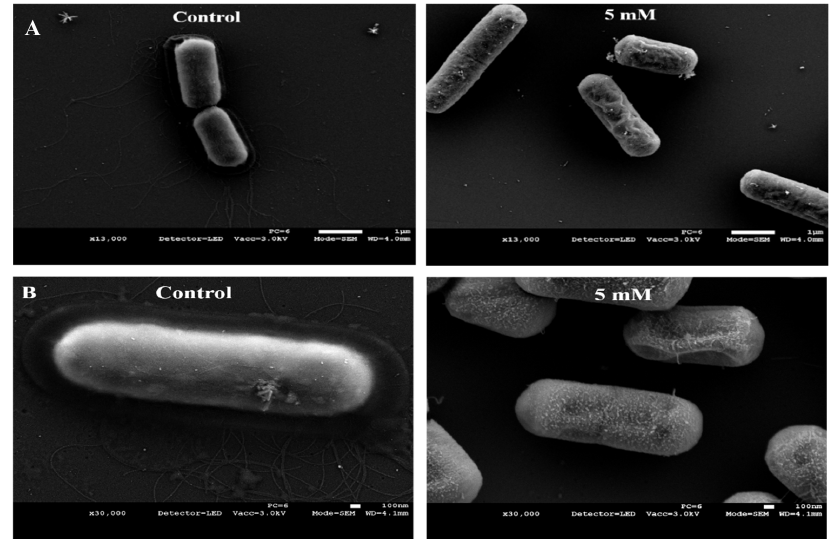
Figure 4. Zn 2+ ions affect cell surface structure and generation of flagella in B. cereus cells. SEM images of B. cereus cells following overnight exposure to 5 mM of ZnCl 2 showing abnormalities in cell surface, as well as complete loss of flagella. Images shown were taken at magnifications of 13,000 × ( A ) and 30,000 × ( B ) with a Jeol JSM-IT-100 LV at 5.0–10.0